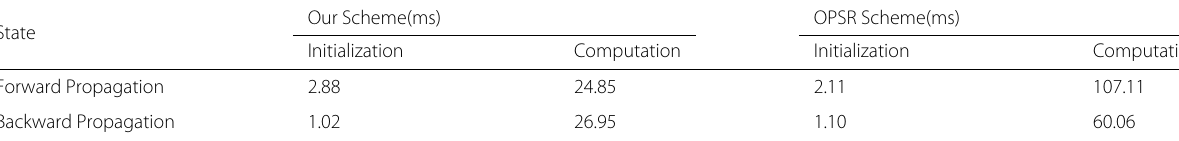
Table 4 Runtime of privacy-preserving LSTM for each training sample